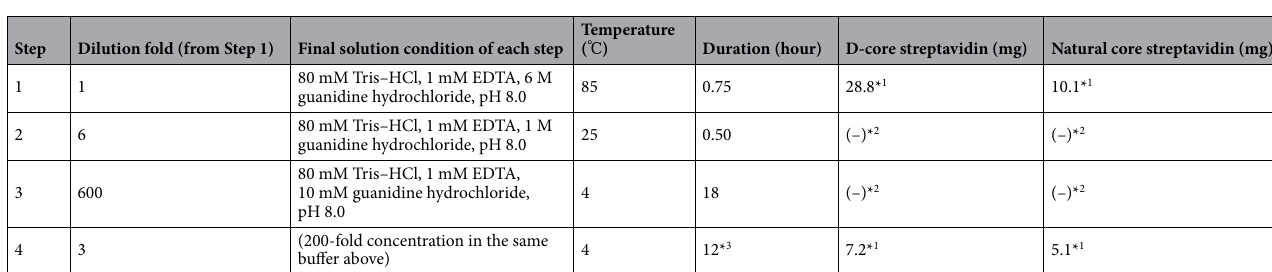
Table 2. Folding recovery of each core-streptavidin. *1: quantitated by UV absorption at 280 nm. *2: not determined. *3: duration time after the final